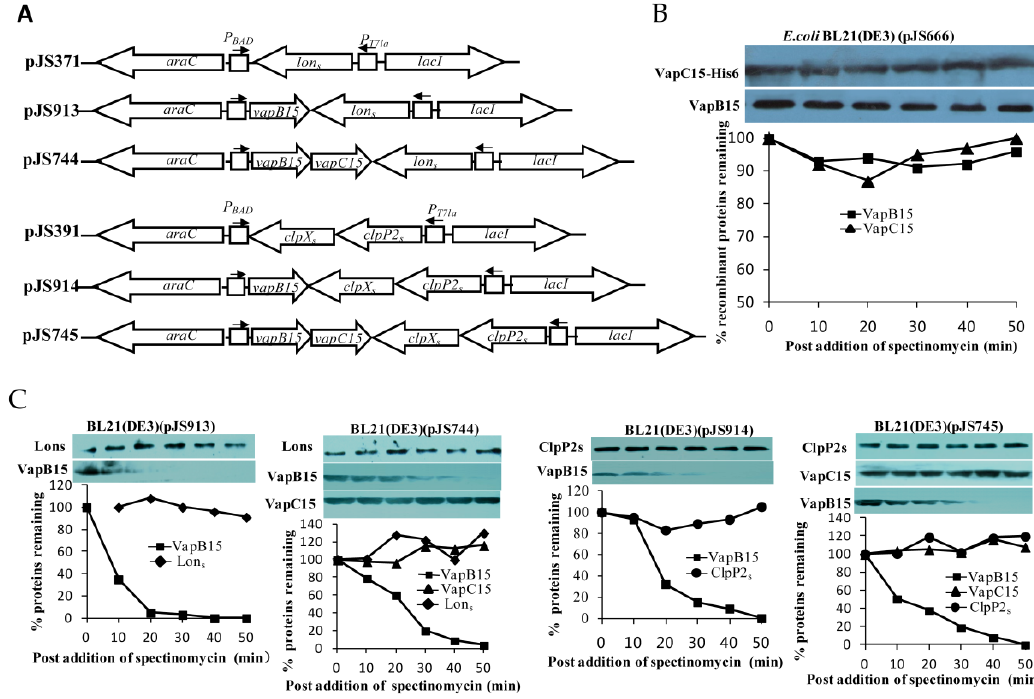
Figure 5. Western blot analyses for the sensitivity of VapB15 and VapC15 to ClpPXP2s and Lons. ( A ) Schematic diagram showing the structure of proteolytic activation plasmids. ( B ) Stability of VapBC15 proteins in E. coli cells. The cells of E. coli BL21 (DE3)(pJS666) (see Figure 2) were grown, induced and translationally stalled as described in Materials and Methods. The treated cells were subjected to Western blot analysis to monitor VapB15 and VapC15 with the respective antibodies. The graph below represents the percentages of the indicated protein amount at each time point compared to that at time zero. ( C ) Stability of the VapBC15 proteins towards ClpPXP2s and Lons. The E. coli cells containing the corresponding plasmids were treated similarly as in ( B ), and subjected to Western blot analysis using the respective antibodies.